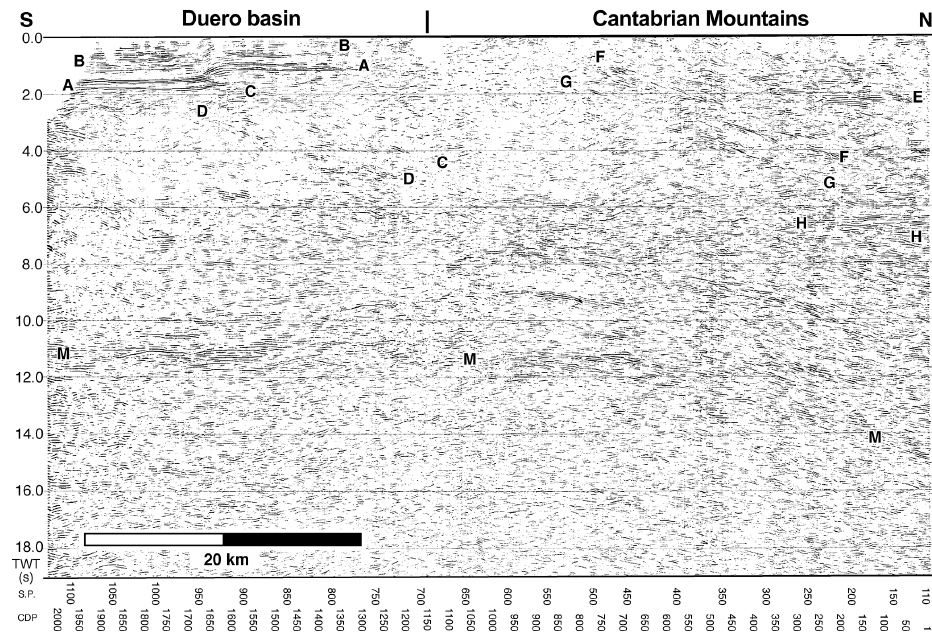
Figure 4. Coherency filtered stack section of ESCIN-2 with the interpretation of the main reflectors and crustal levels described in the text.